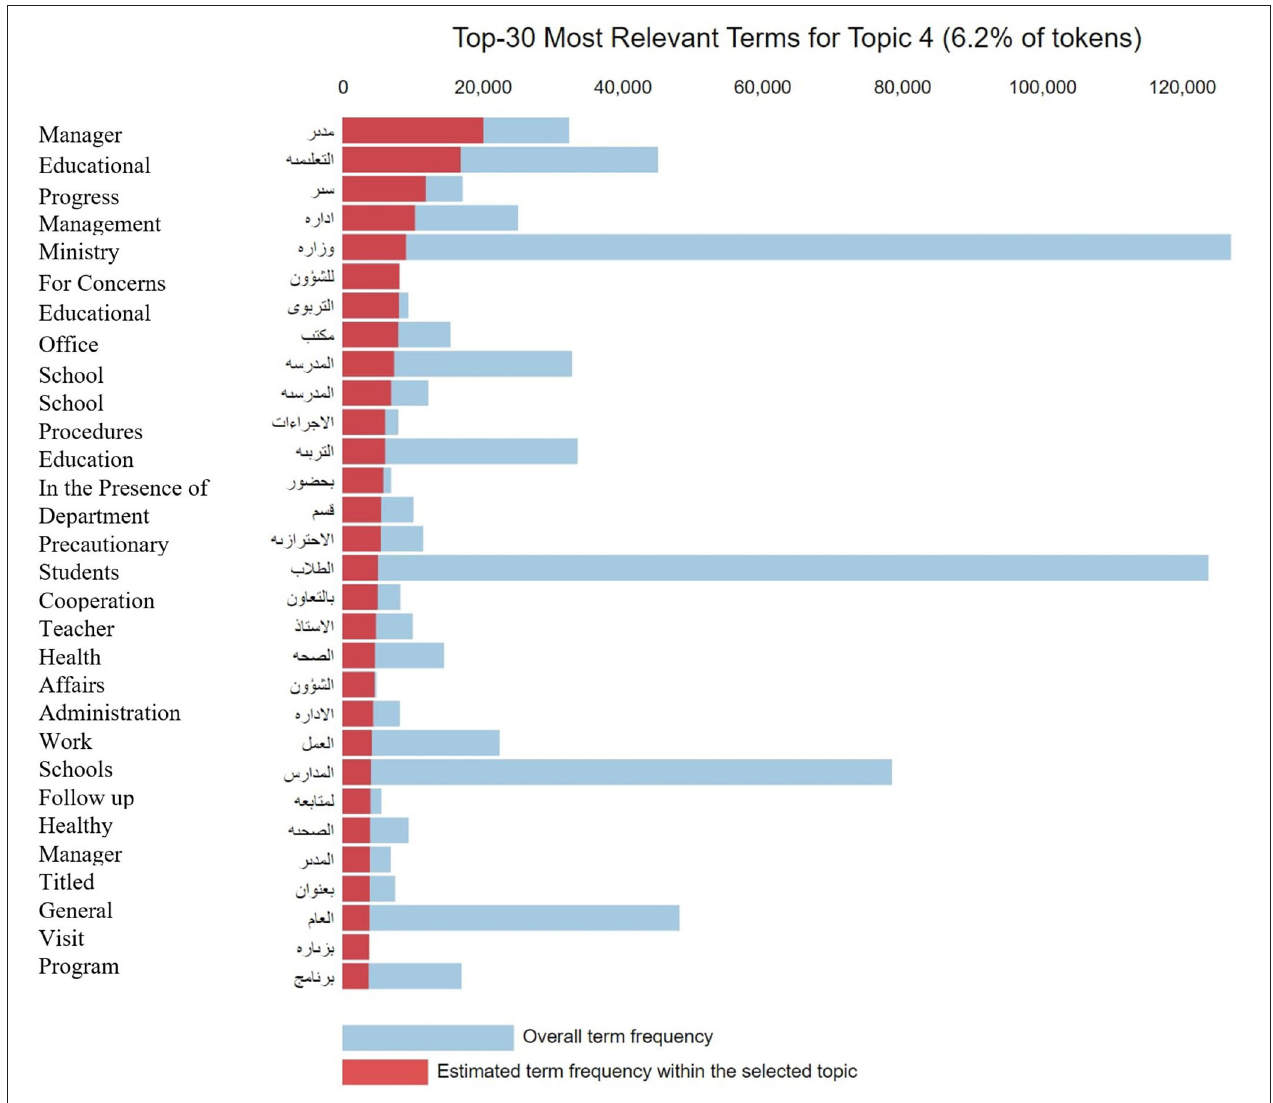
FIGURE 5 | The top 30 most relevant keywords/key terms by frequency (Topic 4).